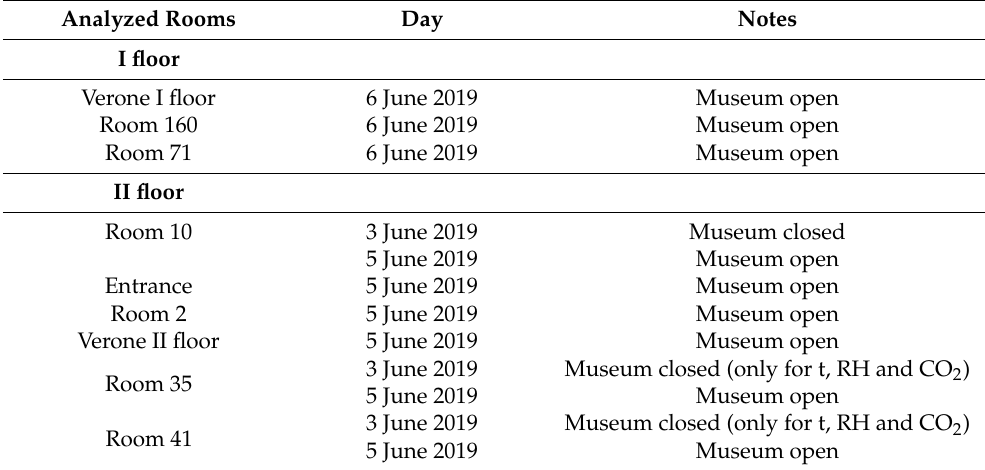
Table 7. Schedule of IAQ measurements in the Uffizi Gallery of Florence.